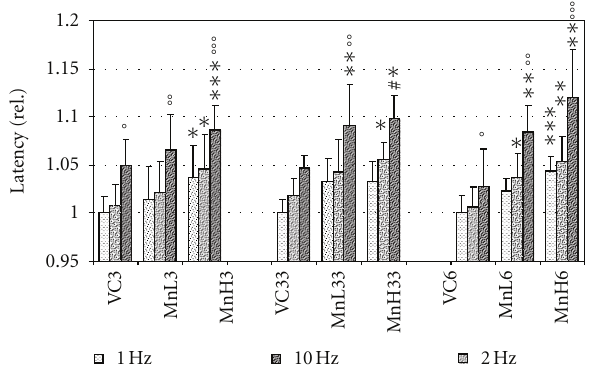
Figure 2: Latency of the somatosensory evoked potential in the control and treated rats, recorded with 1, 2, and 10Hz stimulation frequency (see insert). Mean + SD, n = 8. The data displayed are relative, calculated to the value obtained from the vehicle-treated rats at 1Hz frequency as basis of comparison. ∗ , ∗∗ , ∗∗∗ : P < 0 . 05, 0.01, 0.001 treated versus VC; # , ## : P < 0 . 05, 0.01 MnL33 versus MnL6; ◦ , ◦◦ , ◦◦◦ : 2Hz or 10Hz stimulation versus 1Hz, within one treatment group.